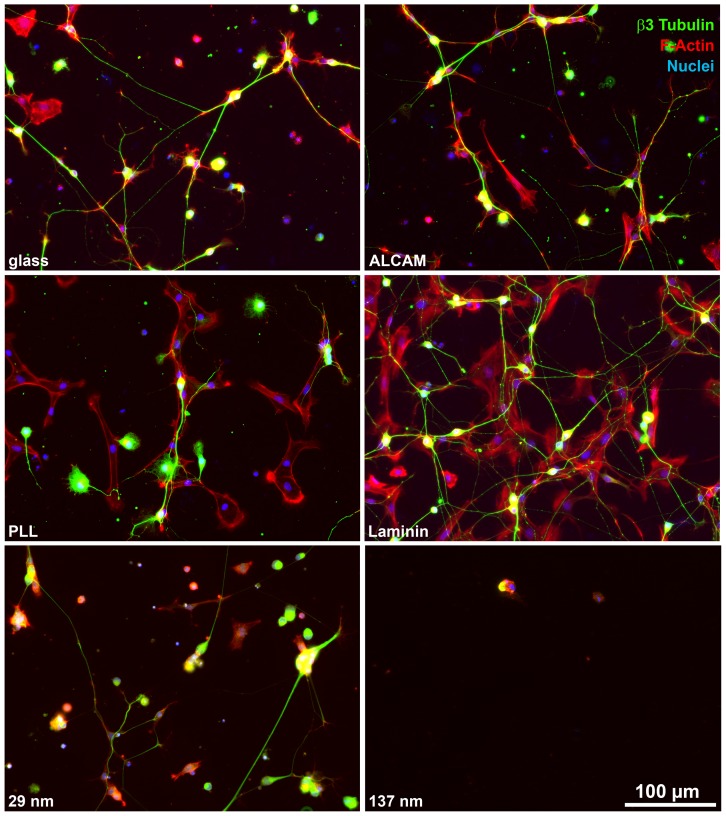
Adhesion of DRG cells to conventional substrates and nanopatterns.Immunofluorescence labeling shows neurons (identified by β3 tubulin staining) and non-neurons (visualized by F-actin labeling) attached to uncoated glass or glass coated with various molecules and to 29 nm or 137 nm nanopatterned ALCAM substrates.